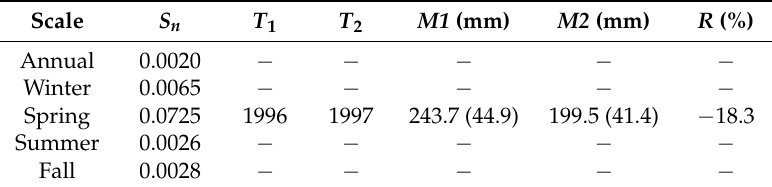
Table 7. Analysis of the temporal variability of annual and seasonal total rainfall at the Bagotville station from 1980 to 2010 using the Lombard method.